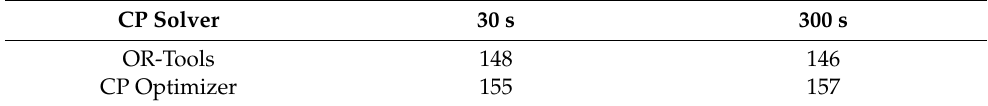
Table 5. Scoring points of CP Optimizer and OR-Tools for FJSSP instances.